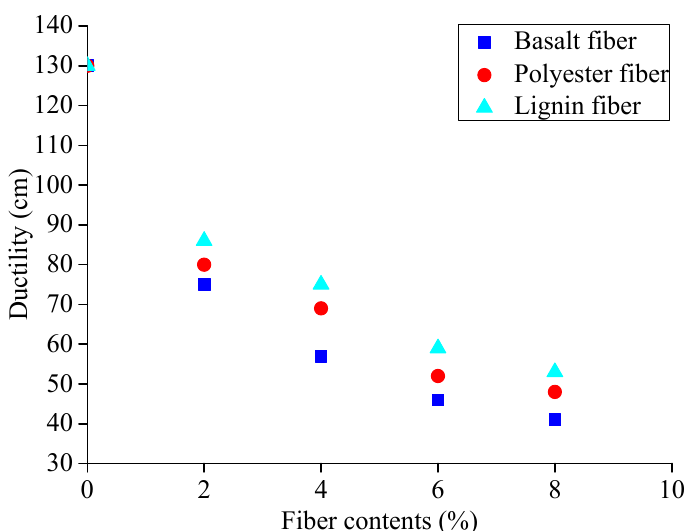
Figure 11. Ductility test results for three kinds of fiber-reinforced asphalt binder, where the testing temperature was set to 15 °C.